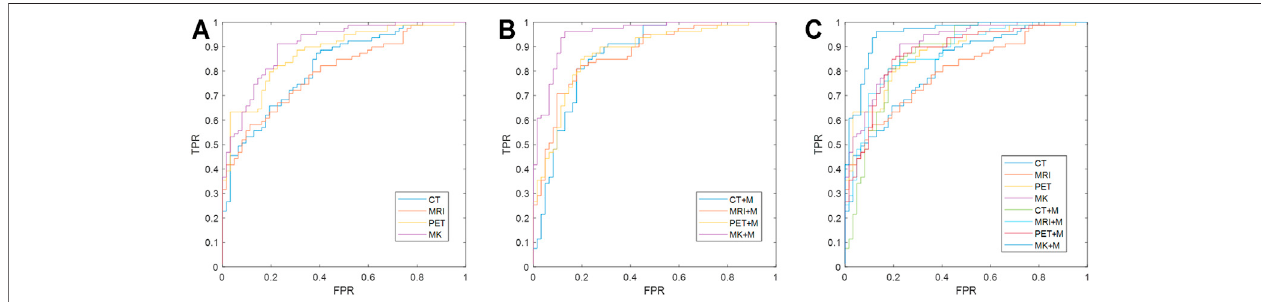
FIGURE 4 | Comparison of receiver operating characteristic curves between different methods. (A) Multi-/single-kernel deep residual network without mask attention operation; (B) multi-/single-kernel deep residual network with mask (MK + M); (C) all receiver operating characteristic curves fuse together. Multi-kernel fusion and introduction of mask can effectively improve prediction effect ofprognosis because multi-kernel mode utilizes information from different modes more effectively and provides greater information support, whereas introduction of mask can provide more precise and accurate information and reduce impact of noise. Multi-kernel andmaskattentionoperation(MK+Mask)aremorefavorablethanothersingle-modemethods[p-valuesare0.00006(CT),0.00003(MRI),0.0104(PET),0.00141(CT+ mask), 0.00007 (MRI + mask), and 0.00692 (PET + mask), respectively, at a con fi dence level of 0.05] using Delong test. Multi-kernel methods without attention mechanism are also signi fi cantly improved compared with other single-mode methods using Delong test [p-values are 0.017 (CT), 0.0003 (MRI), and 0.0103 (PET), respectively]. Abbreviations: FPR, false-positive rate; TPR, true-positive